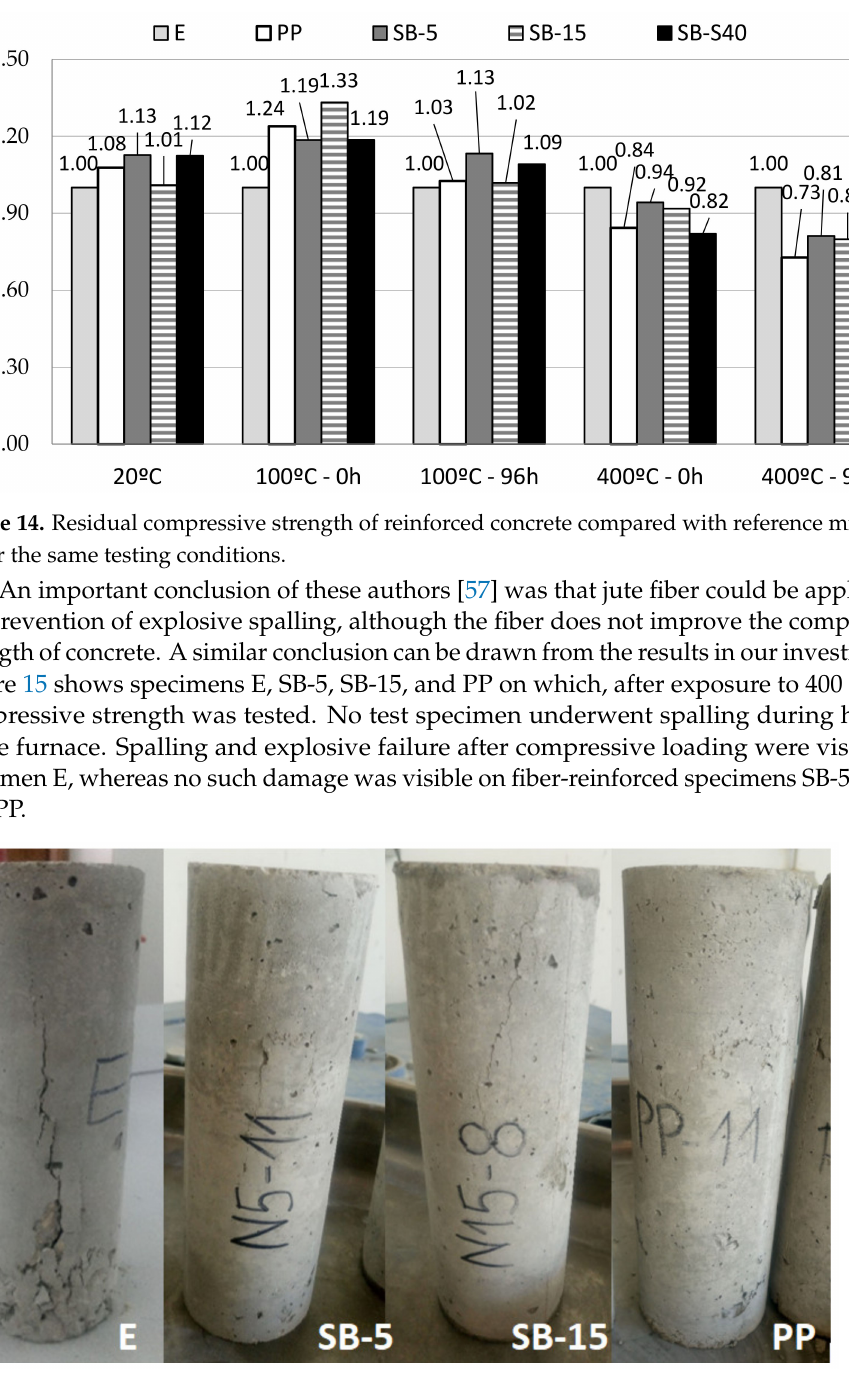
Figure 15. Specimens E, SB-5, SB-15, and PP after exposure to an elevated temperature of 400 ◦